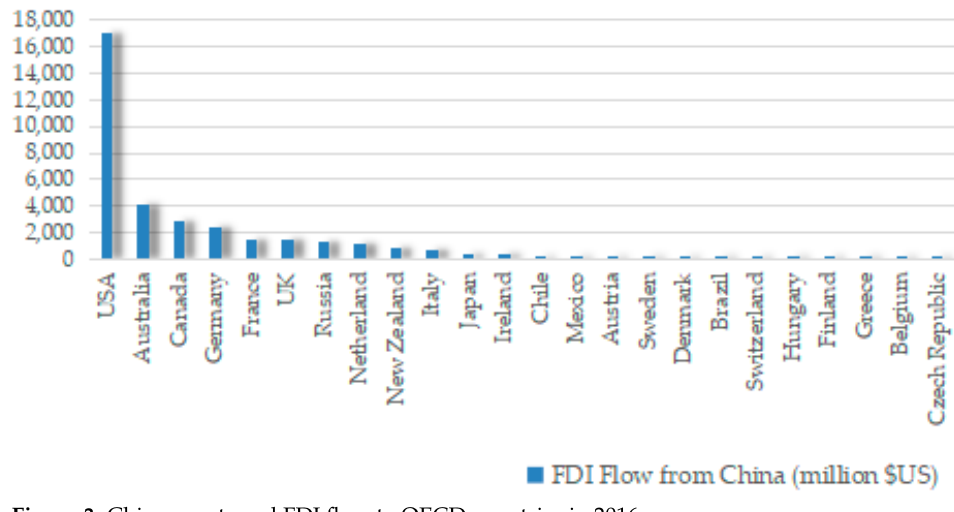
Figure 3. Chinese outward FDI flow to OECD countries in 2016.